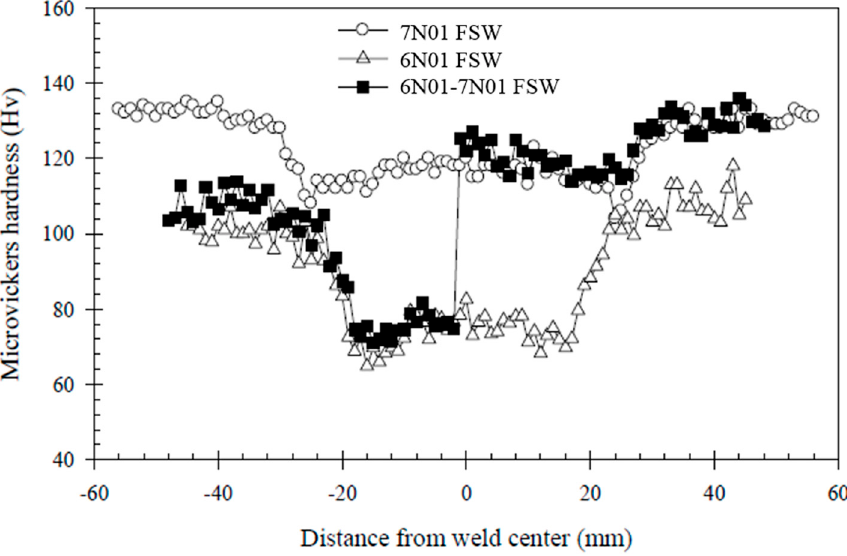
Figure 7. Hardness distributions for the three FSW joints.